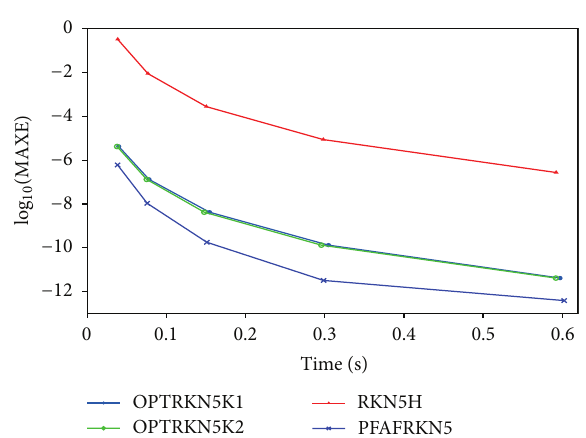
Figure13:EfficiencycurvesforallmethodsoforderfiveforProblem 2 with ℎ = 1/2 𝑖 , 𝑖 = 4, ...,8 .